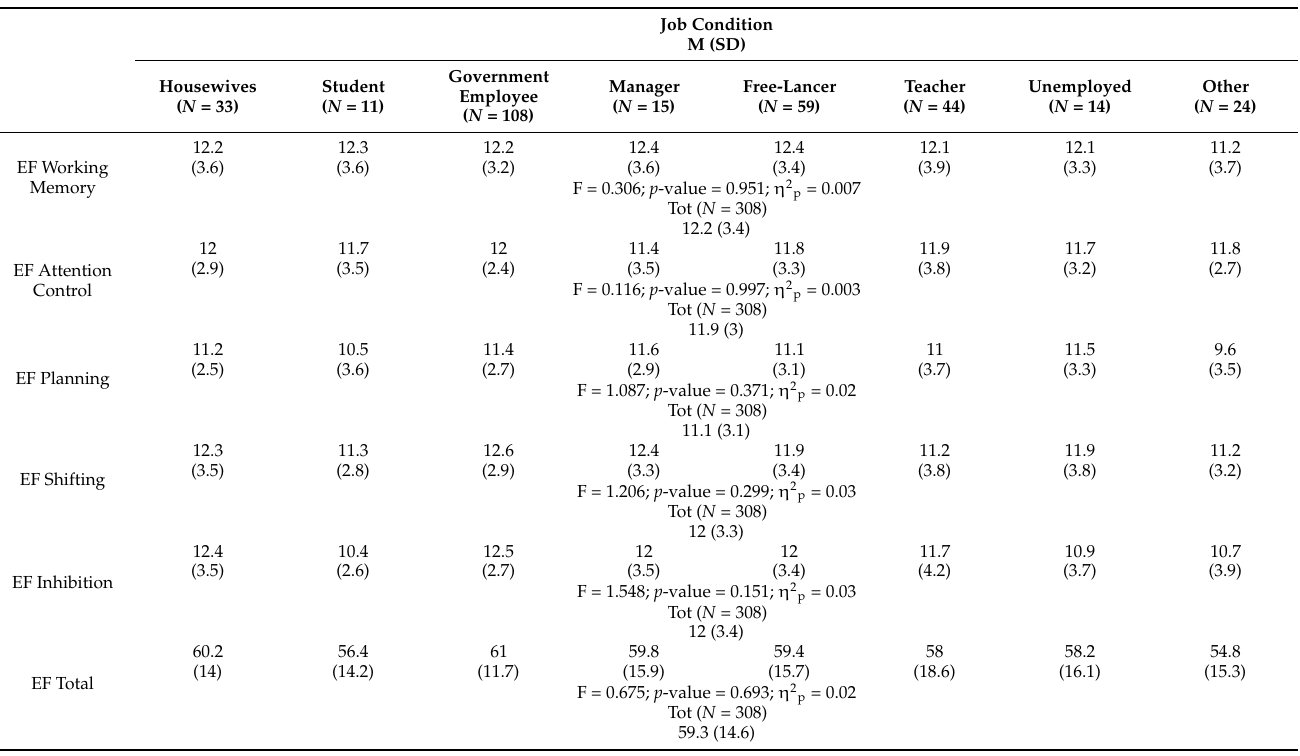
Table 12. EF descriptive data and ANOVA analyses for parental job